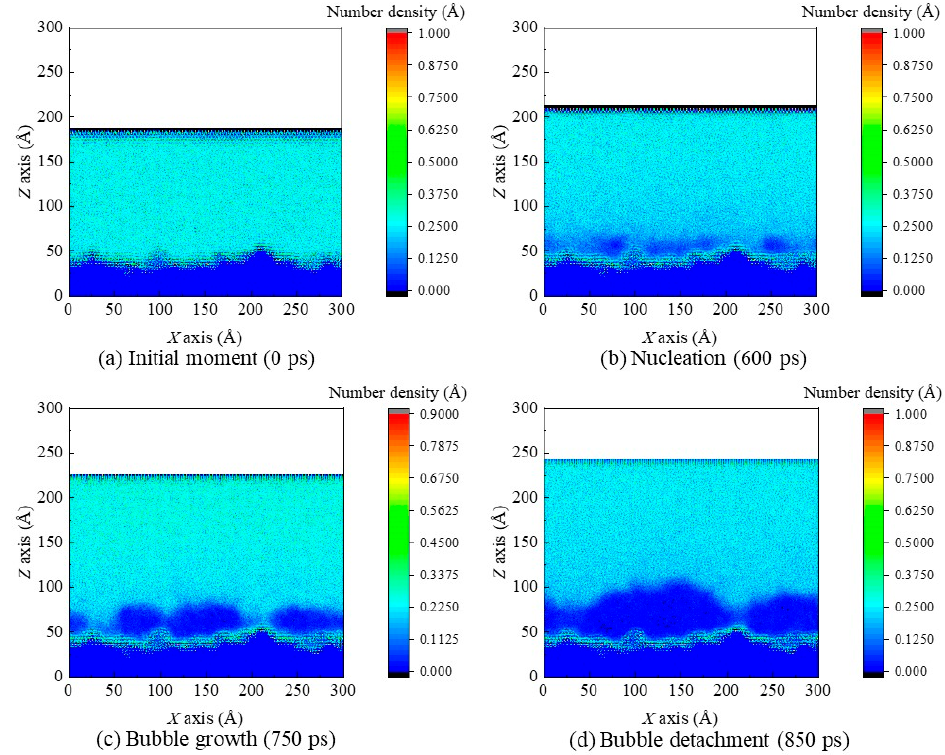
Figure 8. The number density contours of the case α = 1.5 at ( a ) the initial moment, ( b ) the nucleation moment, ( c ) a certain bubble growth moment, and ( d ) the bubble detachment moment.